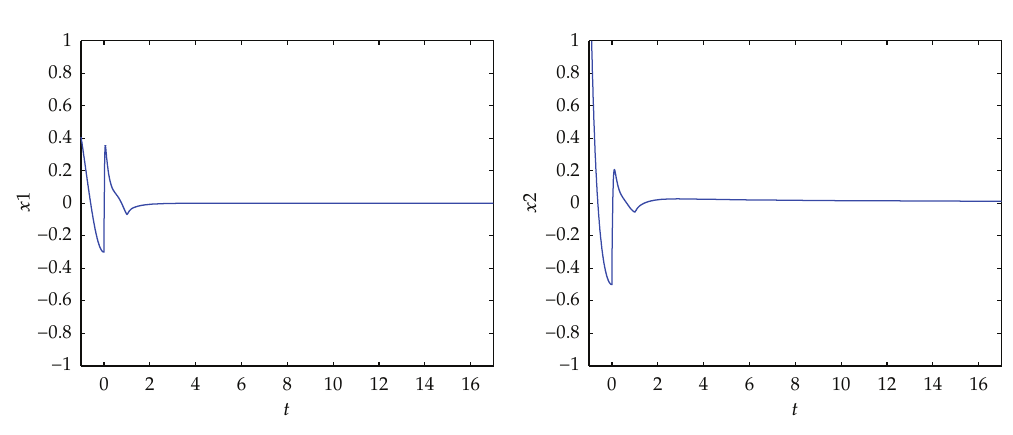
Figure 2: The state trajectories e 1 and e 2 of the network with initial value (cid:2) η 1 (cid:2) t (cid:3) ,η 2 (cid:2) t (cid:3)(cid:3)